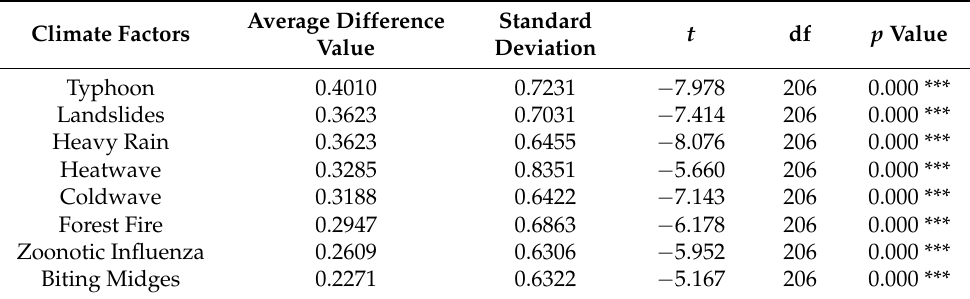
Table 13. Average difference values of travel intention before and after the implementation of adaptational policies. Average Difference Standard t df p Value Climate Factors Value Deviation Typhoon 0.4010 0.7231 − 7.978 206 0.000 *** Landslides 0.3623 0.7031 − 7.414 206 0.000 *** Heavy Rain 0.3623 0.6455 − 8.076 206 0.000 *** Heatwave 0.3285 0.8351 − 5.660 206 0.000 *** Coldwave 0.3188 0.6422 − 7.143 206 0.000 *** Forest Fire 0.2947 0.6863 − 6.178 206 0.000 *** Zoonotic Influenza 0.2609 0.6306 − 5.952 206 0.000 *** Biting Midges 0.2271 0.6322 − 5.167 206 0.000